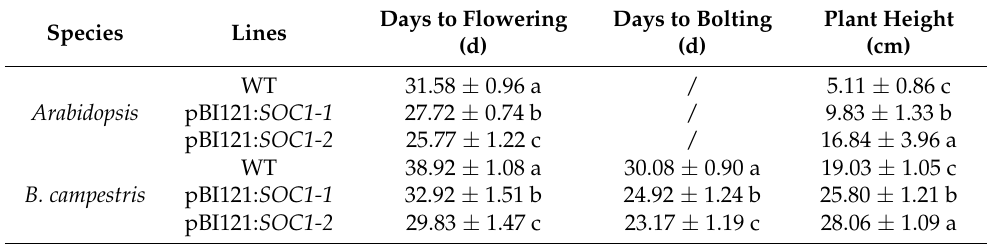
Table 1. Quantification of early bolting and flowering phenotypes in BcSOC1 transgenic lines. Days to Flowering Days to Bolting Plant Height Species Lines (d) (d) (cm) WT 31.58 ± 0.96 a / 5.11 ± 0.86 c Arabidopsis pBI121: SOC1-1 27.72 ± 0.74 b / 9.83 ± 1.33 b pBI121: SOC1-2 25.77 ± 1.22 c / B. campestris pBI121: